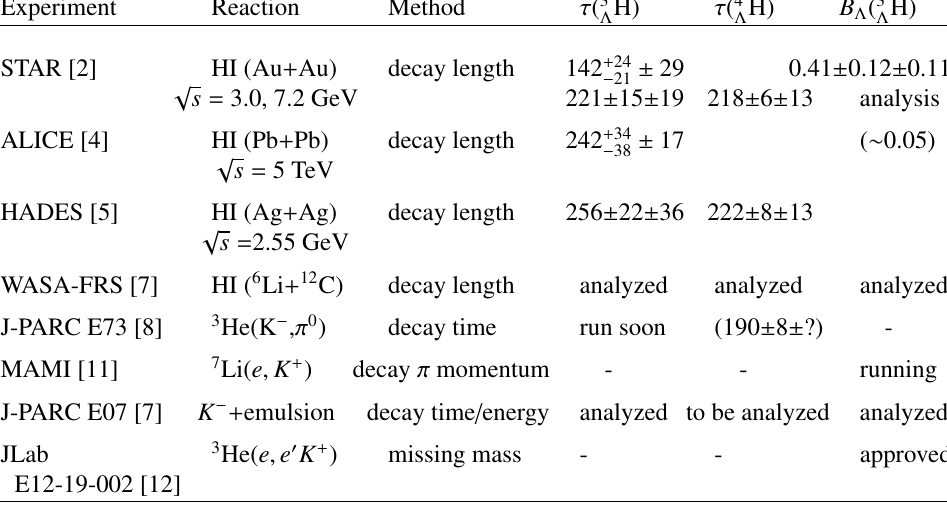
Λ binding energy of 3 3 Λ H) is the measured Λ H in MeV.